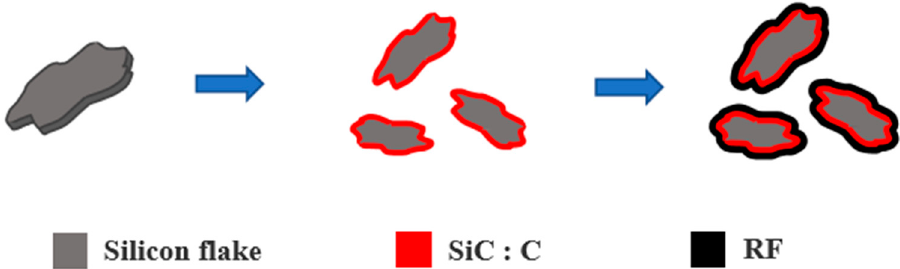
Figure 1. Schematic diagrams of an example of forming a layer of silicon carbide on the surface of a silicon flake followed by the coating of a layer of Resorcinol–Formaldehyde (RF) electrically conductive carbon coating. shows silicon flakes with a coating of RF carbon. The color became light brown. Figure 2c